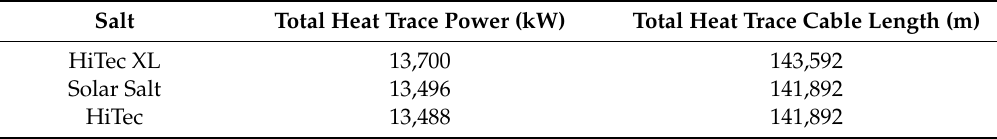
Table 5. Comparison of heat trace systems for three candidate salts for a plant with 388 collector